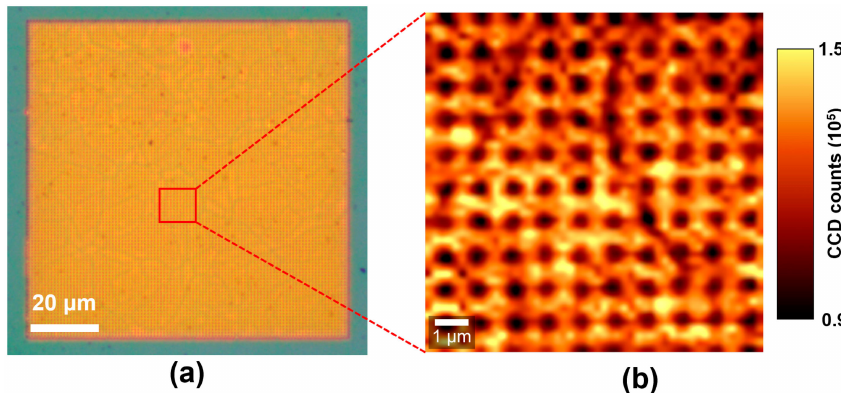
Figure 5. ( a ) Optical microscope image and ( b ) PL mapping image for the hybrid composed of the monolayer MoS 2 and 240-nm-length nanogap